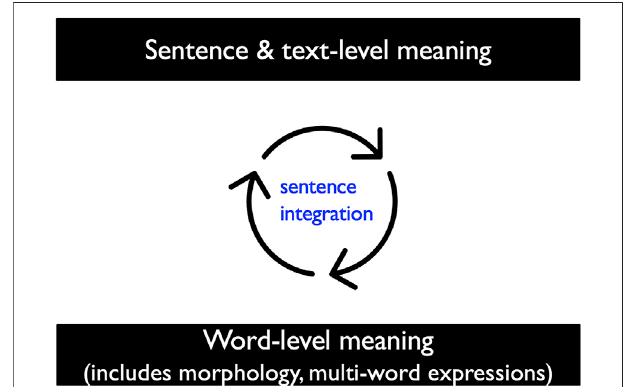
FIGURE 1 | Graphical illustration of the role of sentence integration processes in text reading, modi fi ed from the Reading Systems Framework (Perfetti and Stafura,